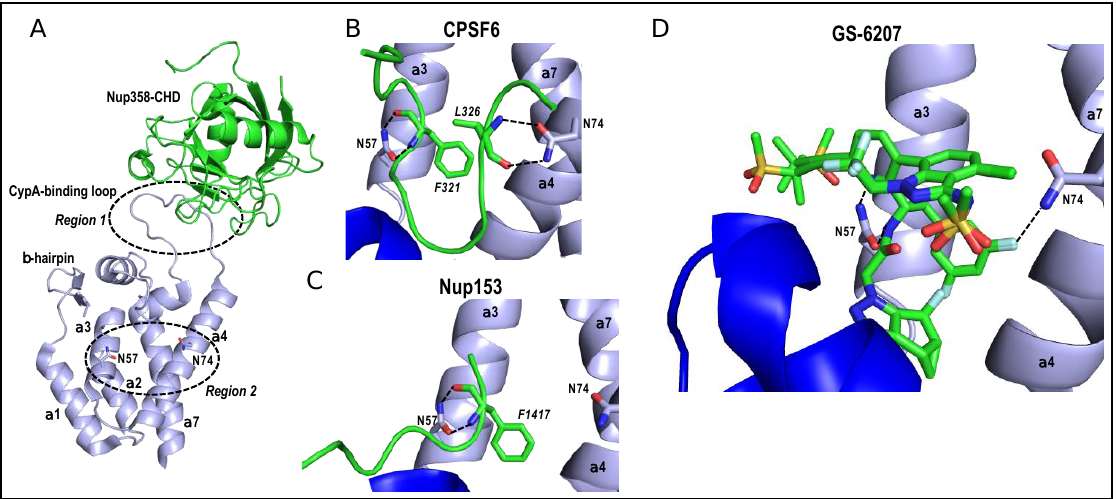
Figure 3. HIV-1 CA and capsomere interaction structures. ( A ) Two common host factor binding regions of CA, which are approximated by dashed circles and labeled Region 1 and Region 2, are superimposed on the structure of the Nup358 cyclophilin-homology domain (CHD) bound to the CA NTD (PDB code 4LQW) [80]. Region 2 is a pocket encompassing alpha helices α 3, α 4, and α 7. Residues Asn57 and Asn74 located on α 3 and α 4, respectively, are shown as sticks. The orientation and labelling of the CA NTD is preserved from Figure 2A. ( B ) Structure of HIV-1 hexamer capsomere bound by CPSF6 residues 313 – 327 (green; PDB code 4U0B) [31]. Backbone atoms of CPSF6 residues Phe321 and Leu326, which are shown as sticks with italicized labels, interact with CA residues Asn57 and Asn74, respectively (dashed lines). The CTD visible in the lower left (dark blue) is from a neighboring CA molecule. ( C ) Interaction of Nup153 residues 1407-1423 (green) with HIV-1 CA hexamer (PDB code 4U0D) [31]. The backbone atoms of Phe1417 interact with CA residue Asn57, akin to CPSF6 residue Phe321 (compare with panel B). CA residue Asn74, by contrast, is distal from the Nup153 peptide. ( D ) Interaction of the antiretroviral inhibitor GS-6207 in the Region 2 binding pocket (PDB code 6VKV) [81]. The drug crystallized in two different binding orientations, both of which are shown. Interactions with CA residues Asn57 and Asn74 are highlighted. Stick colorings in panels A – D: red, oxygen; blue, nitrogen; yellow, sulfur; light grey, fluorine.